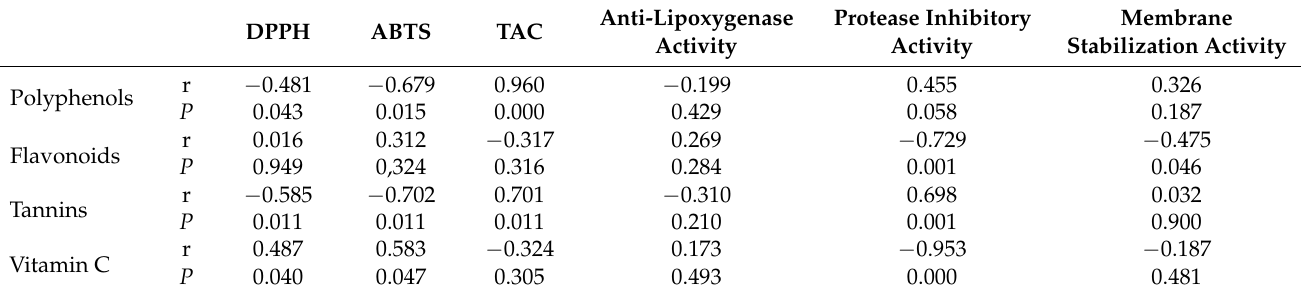
Table 4. Pearson (r) correlation of phytochemicals with antioxidant and anti-inflammatory activities. DPPH